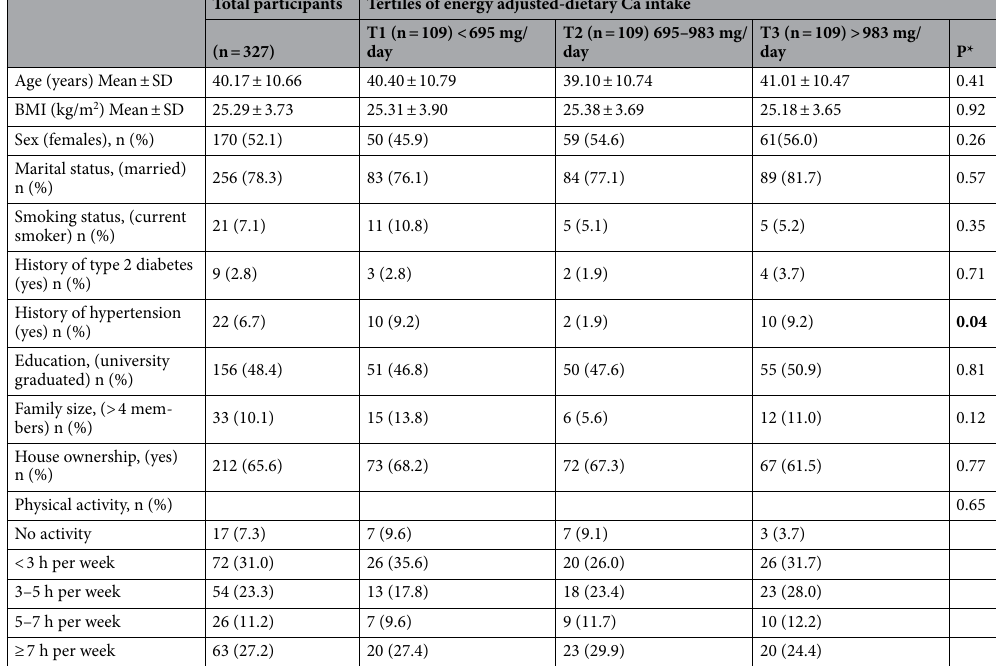
Table 1. Characteristics of study participants and their distribution across tertiles of energy adjusted- dietary calcium intake. Significant values are in [bold]. *Obtained from ANOVA or chi-squared test, where appropriate.